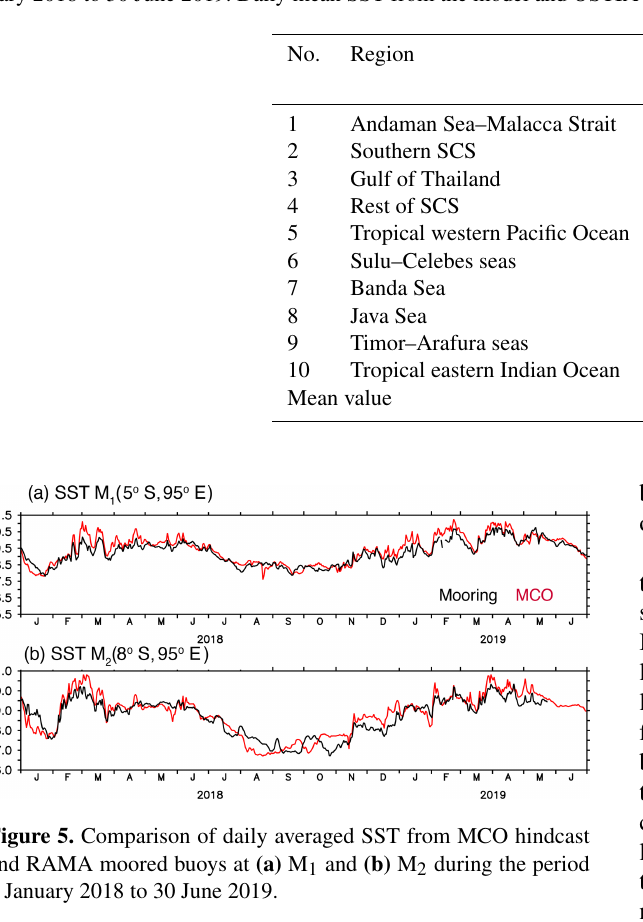
of SST at M 1 and M 2 are 0.94 ◦ C and 0.99 ◦ C, respectively, and the RMSD is smaller than the SD at both